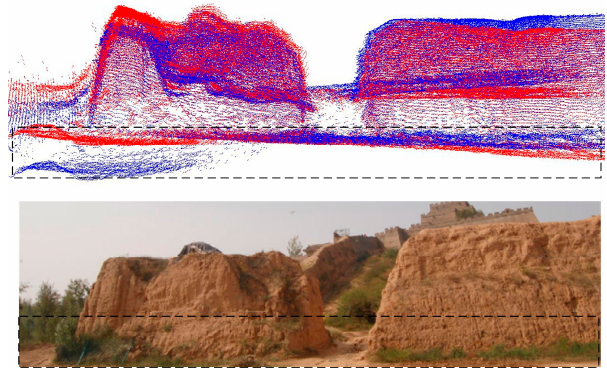
Figure 9. Comparison between different point clouds modeling for a typical Great Wall segment (the upper image is the point cloud, red: with iterative closest point (ICP), blue: with ICP plus graph optimization).